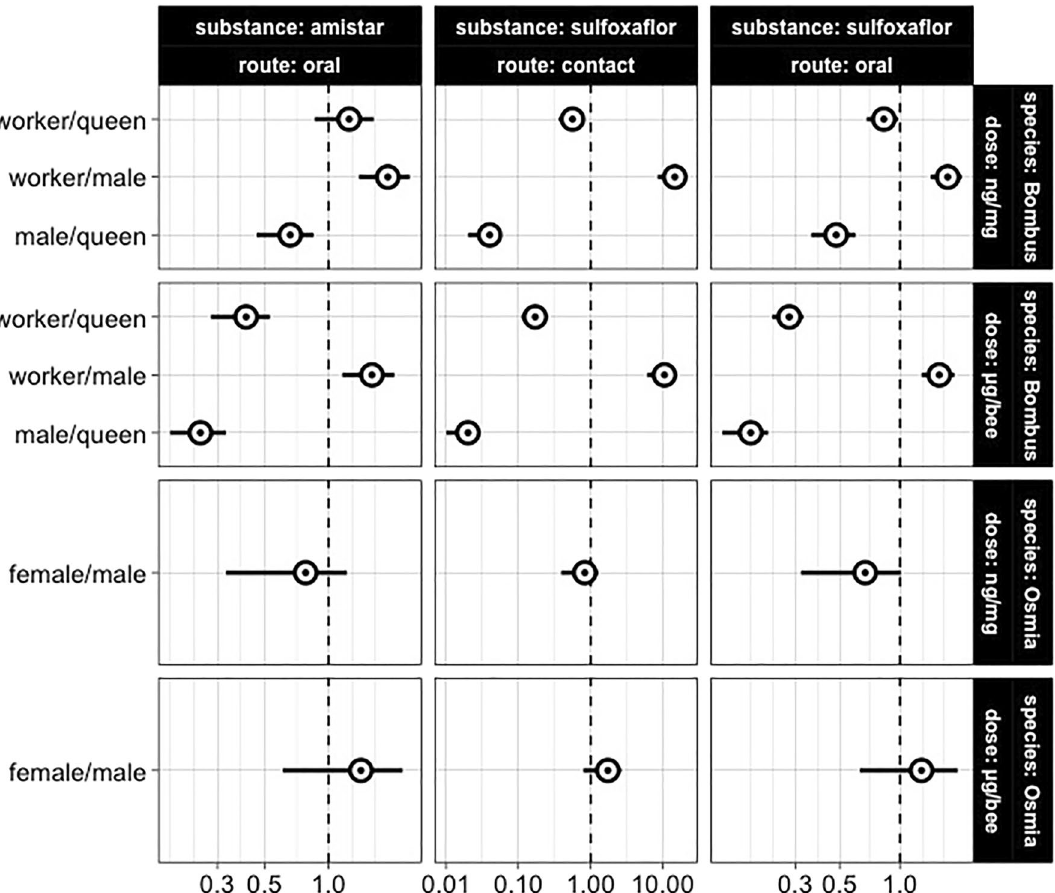
Figure 2. The intra-specific sensitivity across sexes and castes of B. terrestris and O. bicornis. Dots represent the Sensitivity Ratios (SR), while error bars represent the 95% confidence interval. The y-axis reports the relevant comparisons, while the x-axis reports the SR (dimensionless). The vertical dashed line (SR = 1) represents the case where the two compared LD 50s are equal, below which the sensitivity is higher. SRs are considered significant when their confidence bounds do not cross